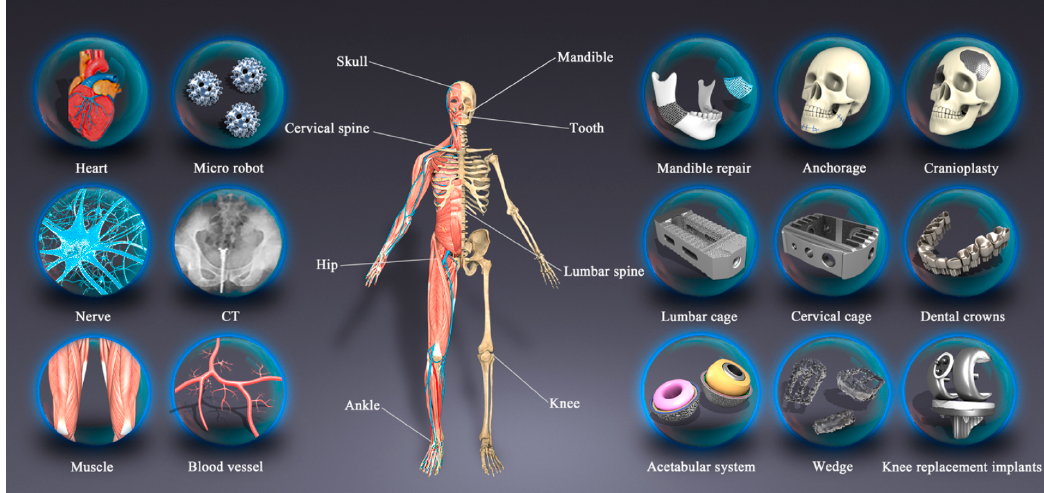
Figure 9. Application of AM in biomedical field. Figure adapted from reference [9].